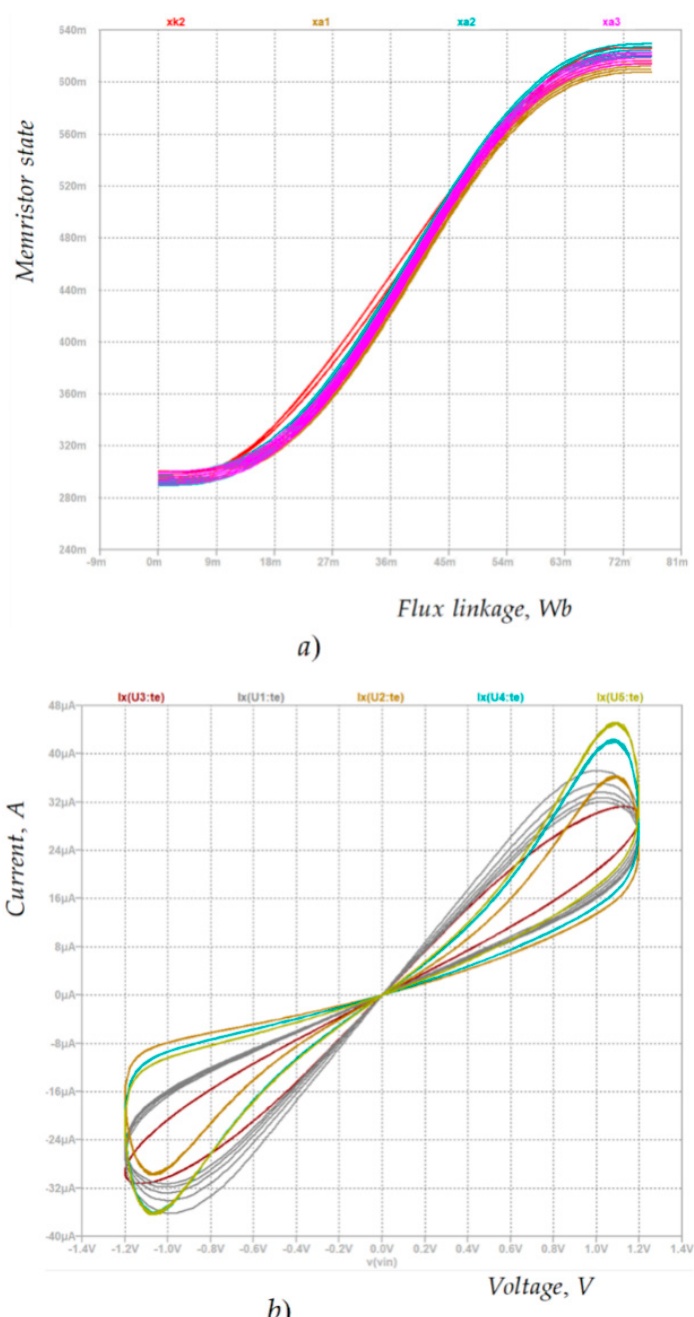
Figure 4. ( a ) State–flux relationships of the standard hafnium dioxide memristor models K 6 and K 7 , and the modified models A 6 , A 7 , and A 8 , with a sinusoidal voltage magnitude of 1.2 V and a frequency of 5 Hz; ( b ) The corresponding current–voltage relationships of the considered hafnium dioxide memristor